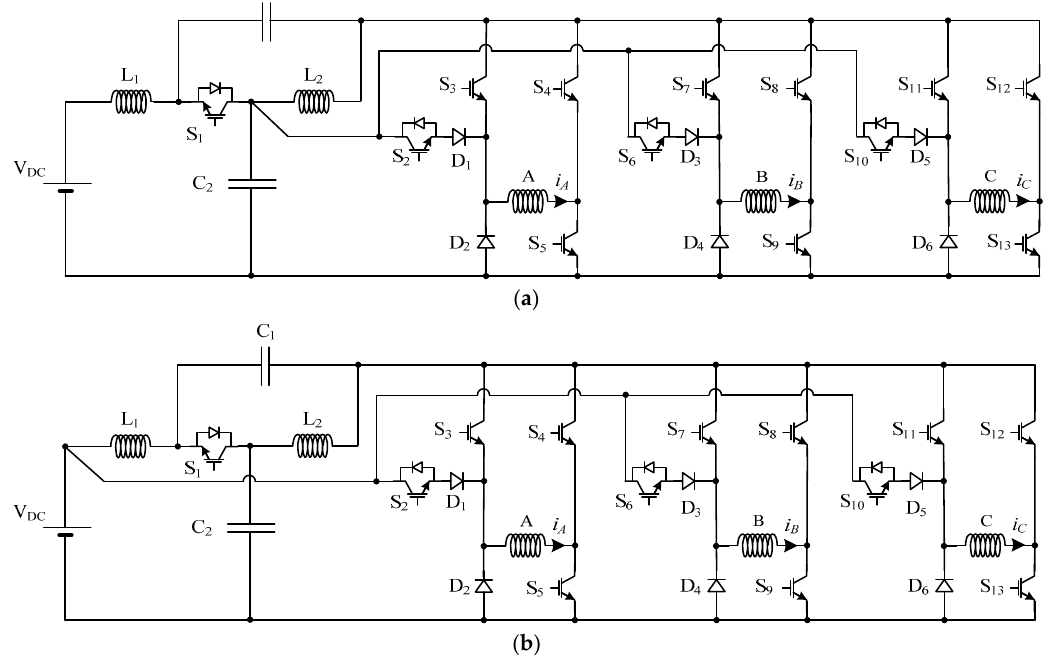
Figure 21. Converters based on the impedance source network with multilevel capability ( a ) with fixed asymmetrical voltages ( b ) with variable asymmetrical voltages.